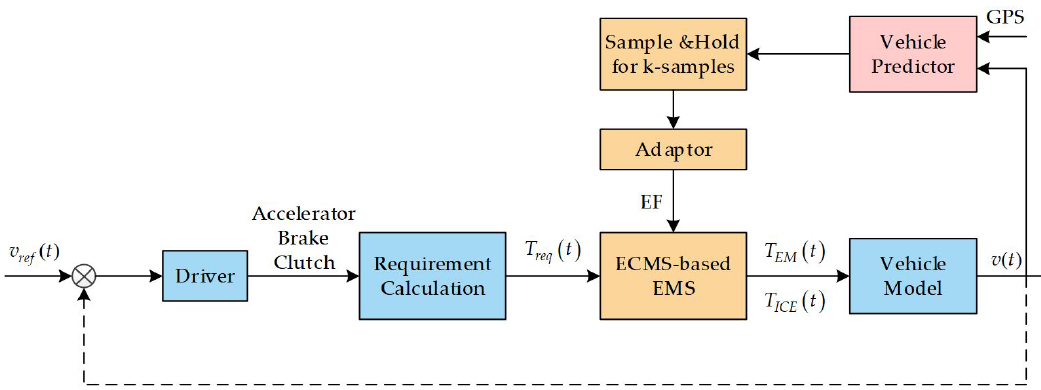
Figure 9. Flow chart of the speed predictive